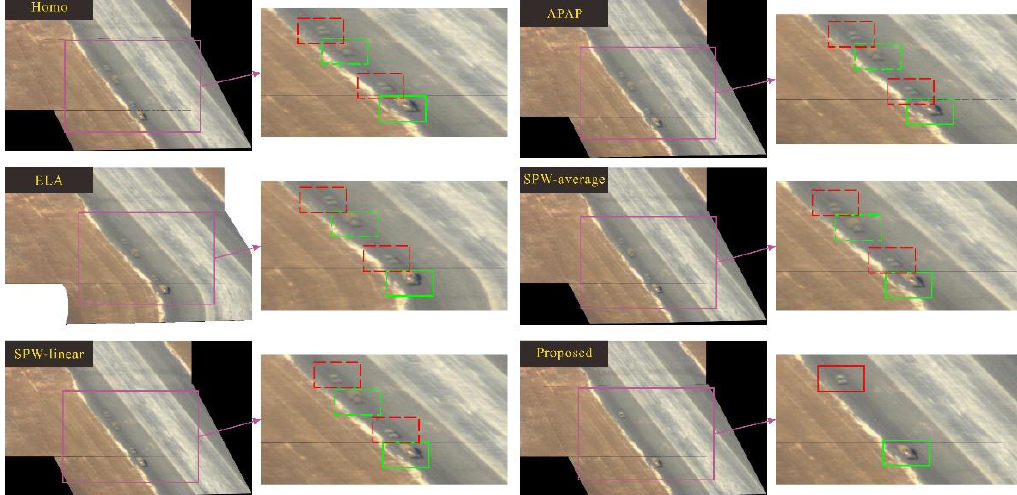
Figure 12. Comparison between the proposed method and SOTA methods on eg03 data.